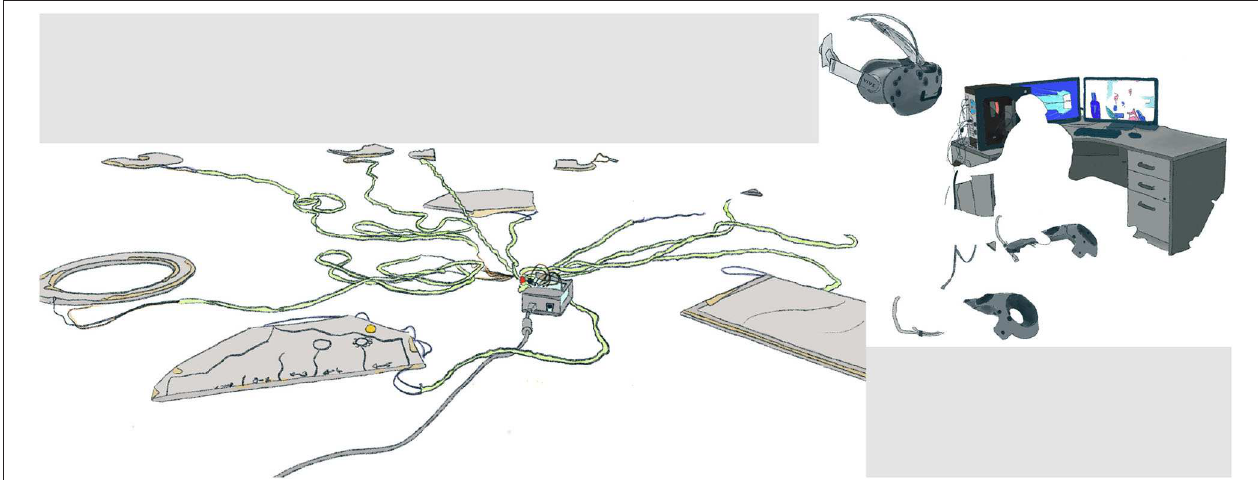
FIGURE 3 | Different illustrations of acting as a game in different contexts with human and non-human actors. Both illustrations have all human actors removed. To the left, a prototype of music pads refocuses our view on the mess of cables, whereas to the right, the context of a VR scenario indicates the relevance of not just the technological artifacts but the necessity of furniture to enable play. Note that non-essential actors as well as human actors create artificial white space.